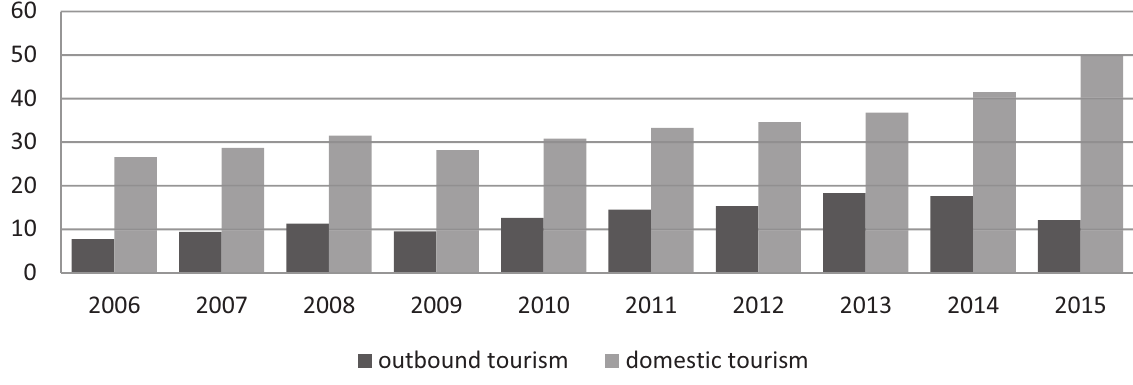
Figure 1. Dynamics of outbound tourism of the Russian citizens and domestic tourist flows over the past 10 years, mln. people, according to the data (Ofitsialnaya